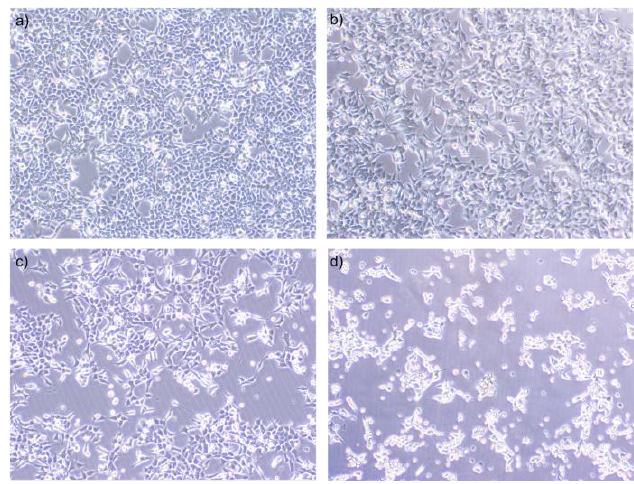
Figure 2. Morphological examination (10× magnification) of NaB treated HCT116 cells under a light microscope (Olympus CKX-53). HCT116 colon cancer cells were seeded to six well plates and the next day they were treated with 6.25–50 mM concentrations of NaB for 24 h. ( a ) Cells treated without NaB; ( b ) Cells treated with 12.5 mM NaB; ( c ) Cells treated with 25 mM NaB; and ( d ) Cells treated with 50 mM NaB. Cells began to lose contact and detach with increasing concentrations of NaB. Healthy morphologic features and cellular integrity completely disappeared and dead cells were clearly seen when cells were treated with 50 mM NaB.